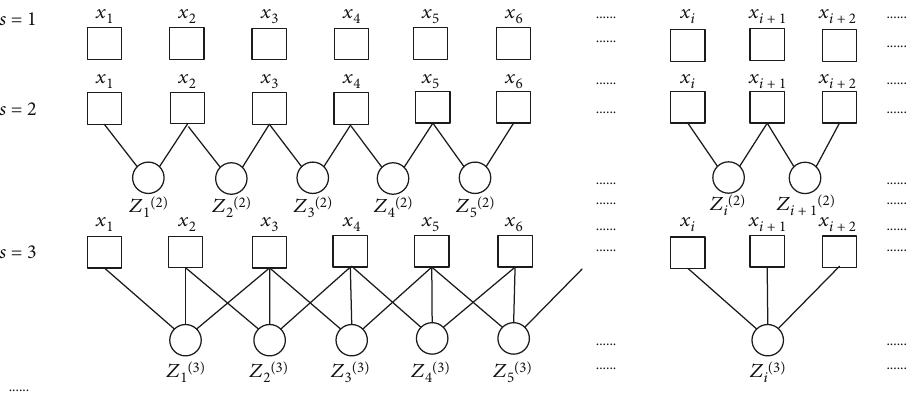
Figure 4: The principle of the fi ne-grained